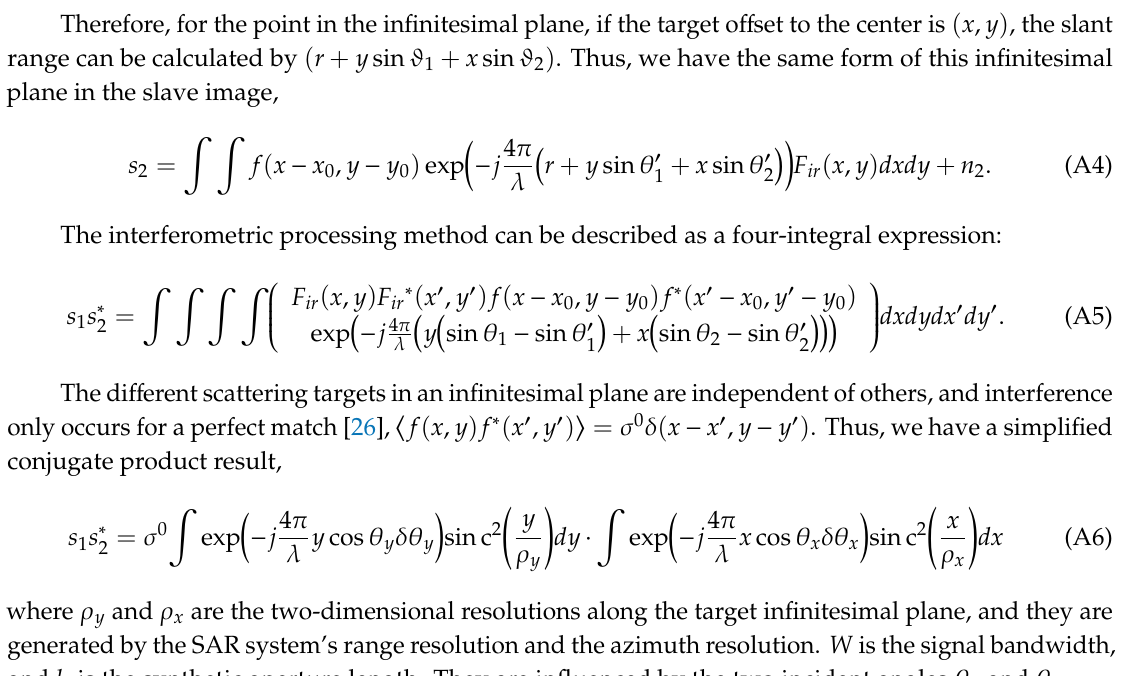
ϑ (left) and ϑ (right). 1 2